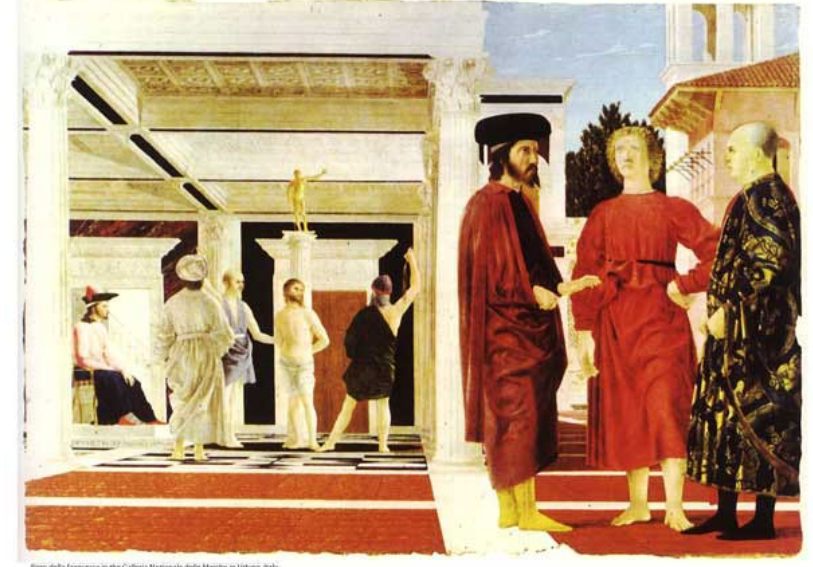
Figure 3 The Flagellation of Christ , c. 1455. Pietro della